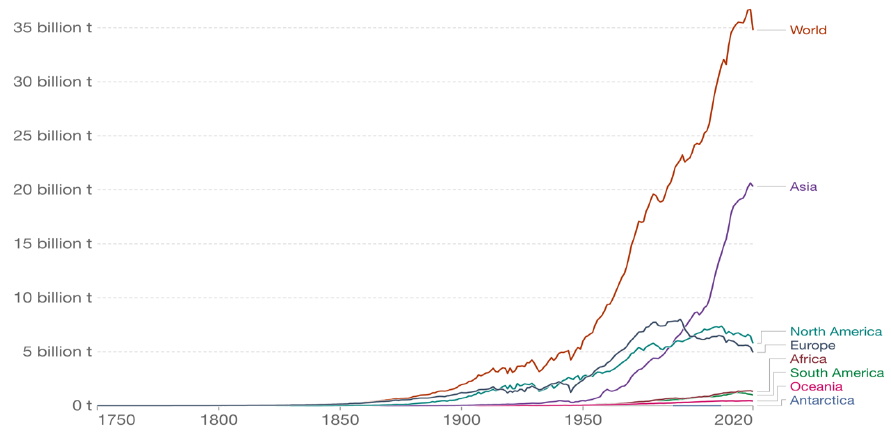
Figure 3. CO 2 emissions for different regions of the world. Source: An online database developed originally by [28], https://ourworldindata.org/co2-emissions (accessed on the 20 August 2022). Table 2. Proportions of CO 2 emissions (in tonnes) across regions of the world. Annual Carbon Dioxide Emissions Regions